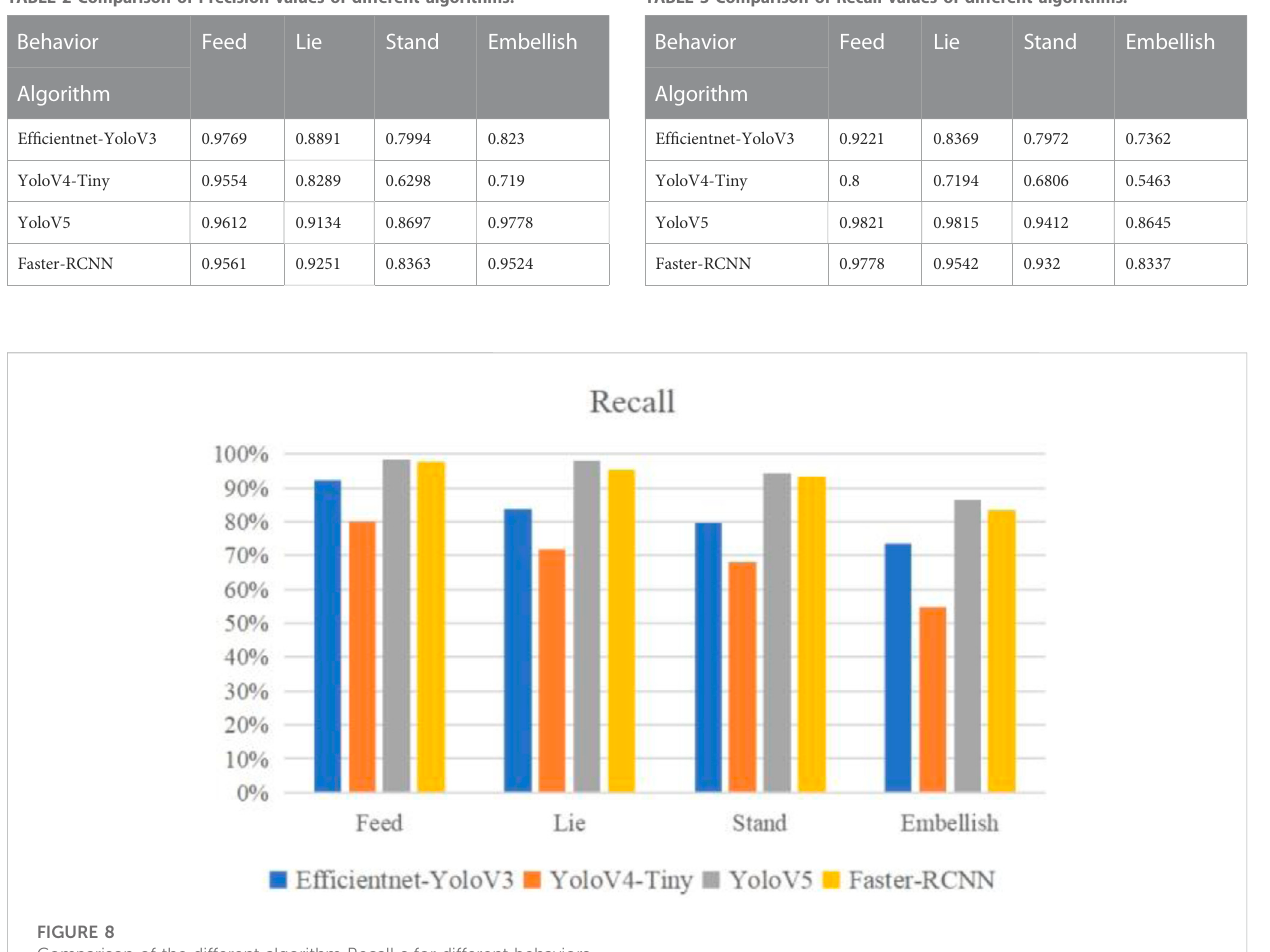
TABLE 2 Comparison of Precision values of different algorithms.